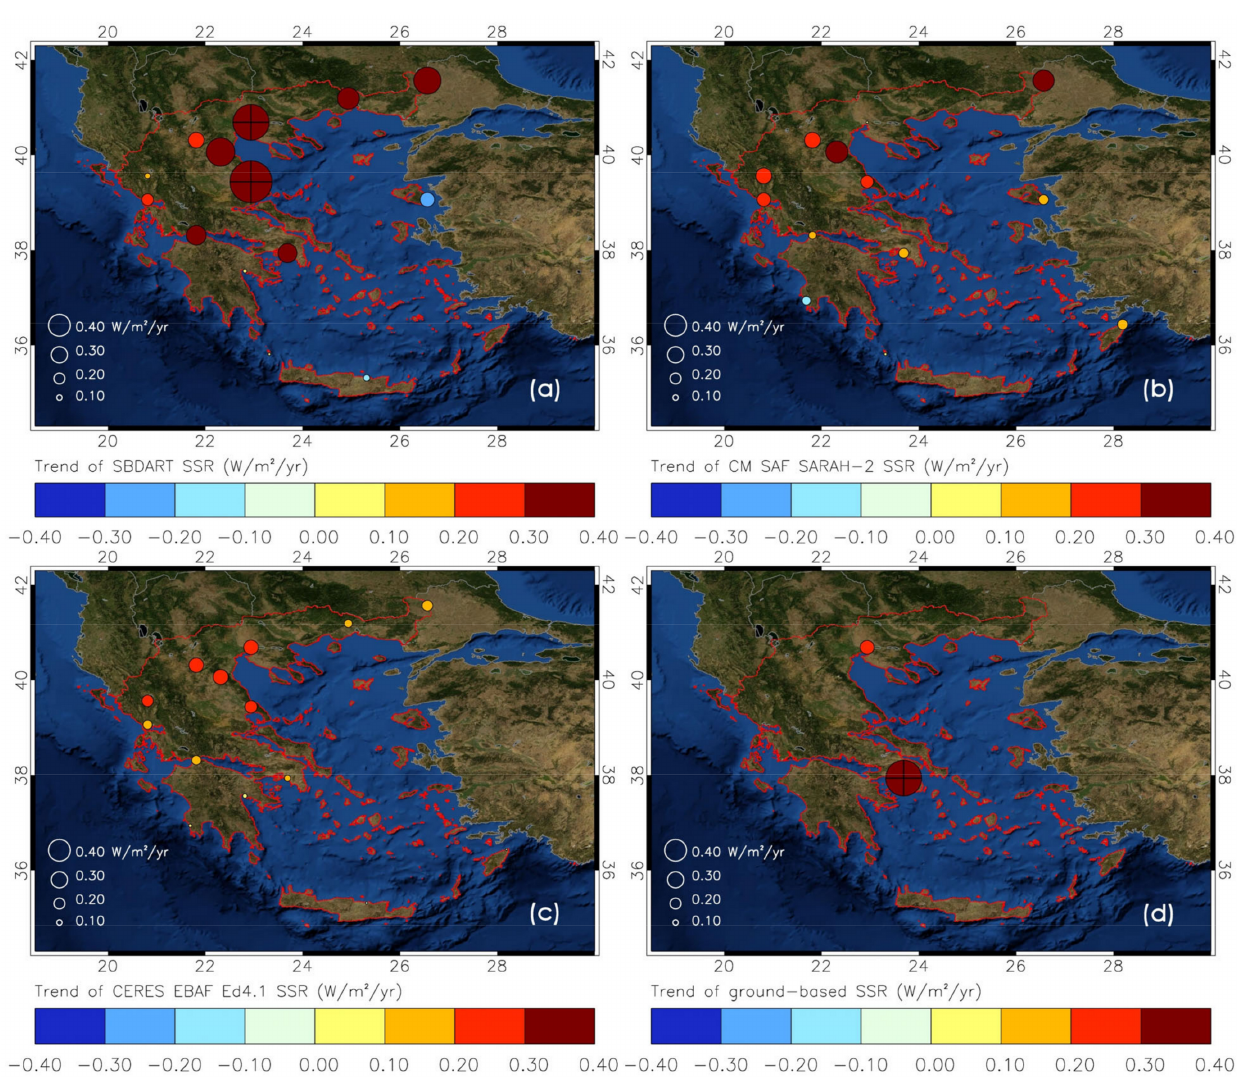
Figure 8. SSR trend for the period 2005–2019 over 16 locations in Greece based on ( a ) data produced here with SBDART, ( b ) CM SAF SARAH-2.1 SSR data and ( c ) CERES EBAF edition 4.1 SSR data. ( d ) SSR trend based on ground-based observations from the stations of Athens and Thessaloniki. Statistically significant trends at the 95% confidence level are indicated with a